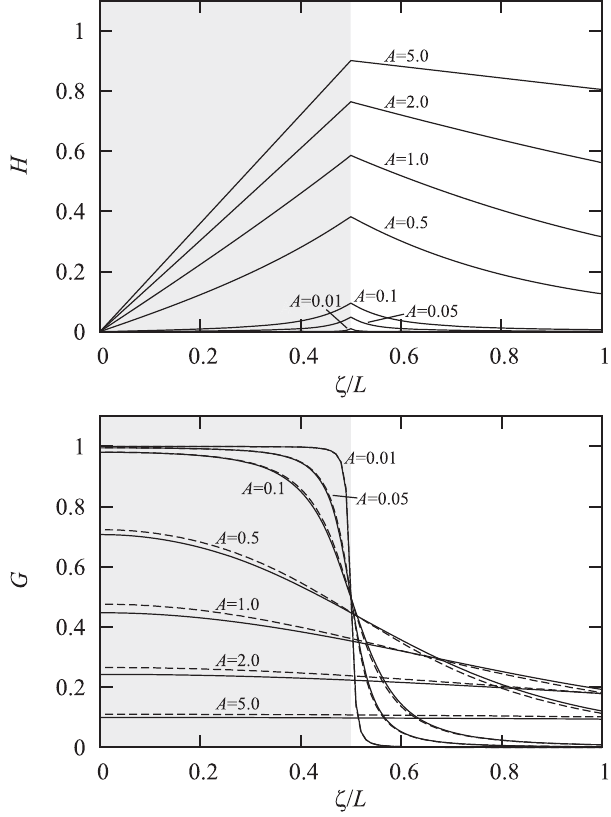
FIG. 1. The function H [top, Eq. (2)] and G [bottom, Eq. (4)] for various aspect ratios A and positive values of ζ =L . H is antisymmetric and G is symmetric to the origin. The bunch extends up to ζ =L ¼ 0 . 5 as indicated by the gray shading. Broken lines in the lower plot show the results of a numerical integration at a radius r ¼ R= 2